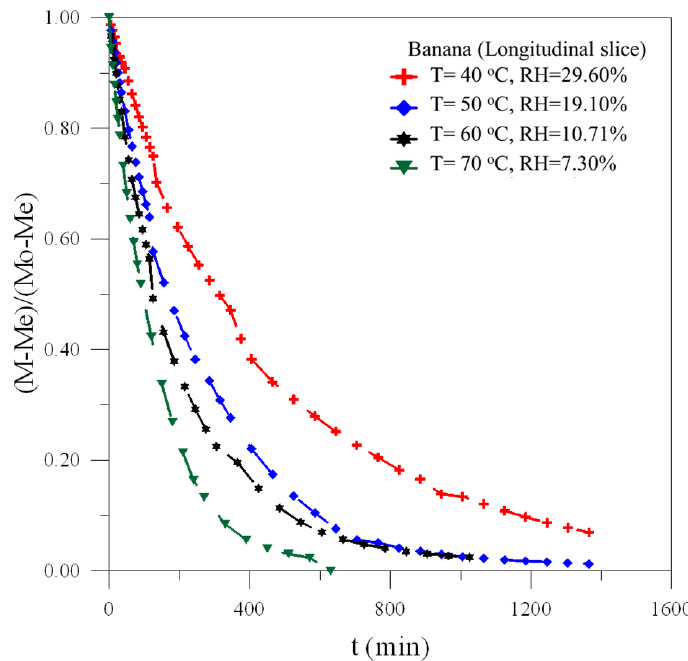
Figure 2. Average dimensionless moisture content of the longitudinal sliced banana as a function of the drying time. T—temperature; RH—relative humidity.